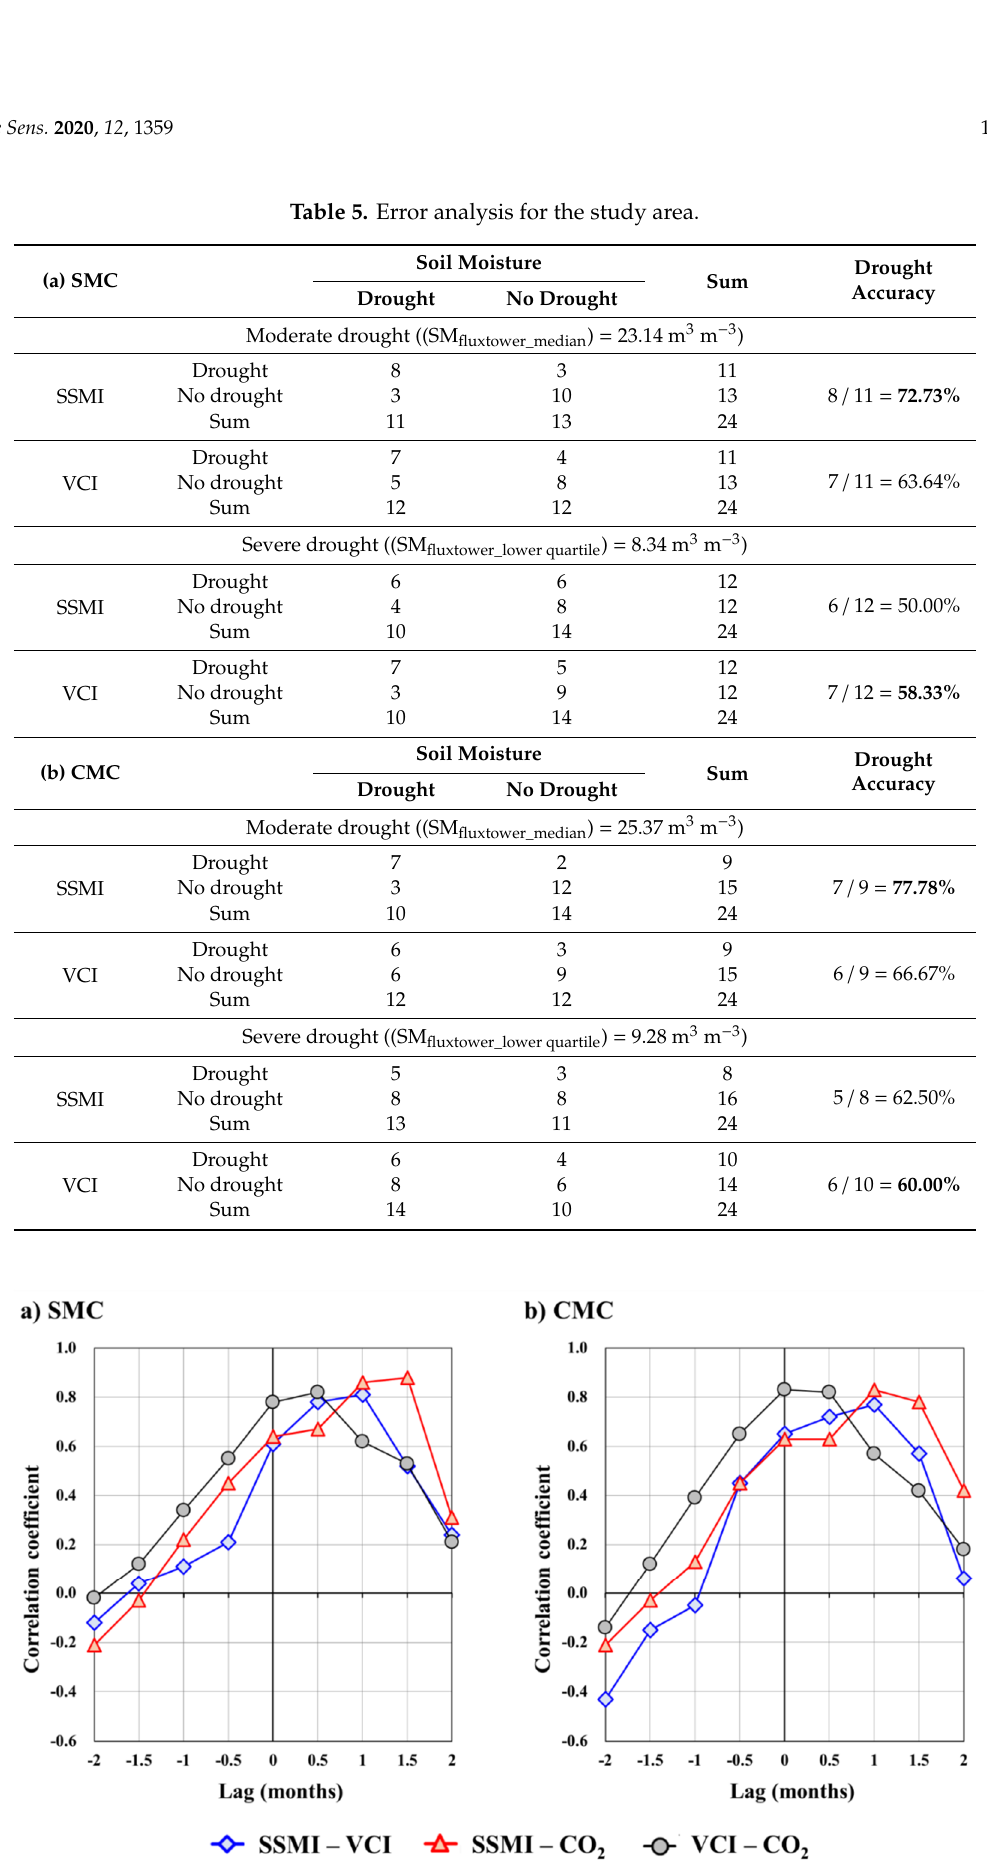
Figure 8. Lag correlation plot of SM, NDVI, and CO 2 flux at at a ) SMC and b ) CMC site.